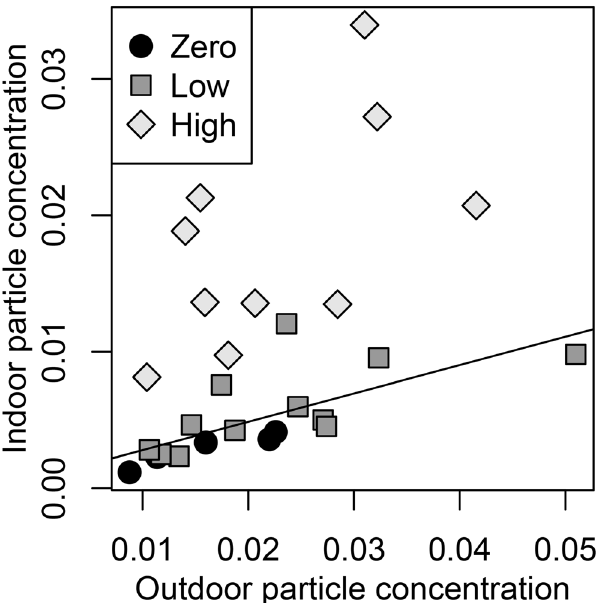
Fig 3. Mean concentrations of particles larger than 5 microns. Concentrations were evaluated with optical particle counters during experiments that occurred over 10 calendar days and when the carpet was exposed or covered in a plastic sheet. Values show particle numbers per cm 3 air. Low occupancy periods had 1 or 2 people sitting, and high occupancy periods had 2 people walking or 8 people sitting. The linear regression is based on zero and low occupancy